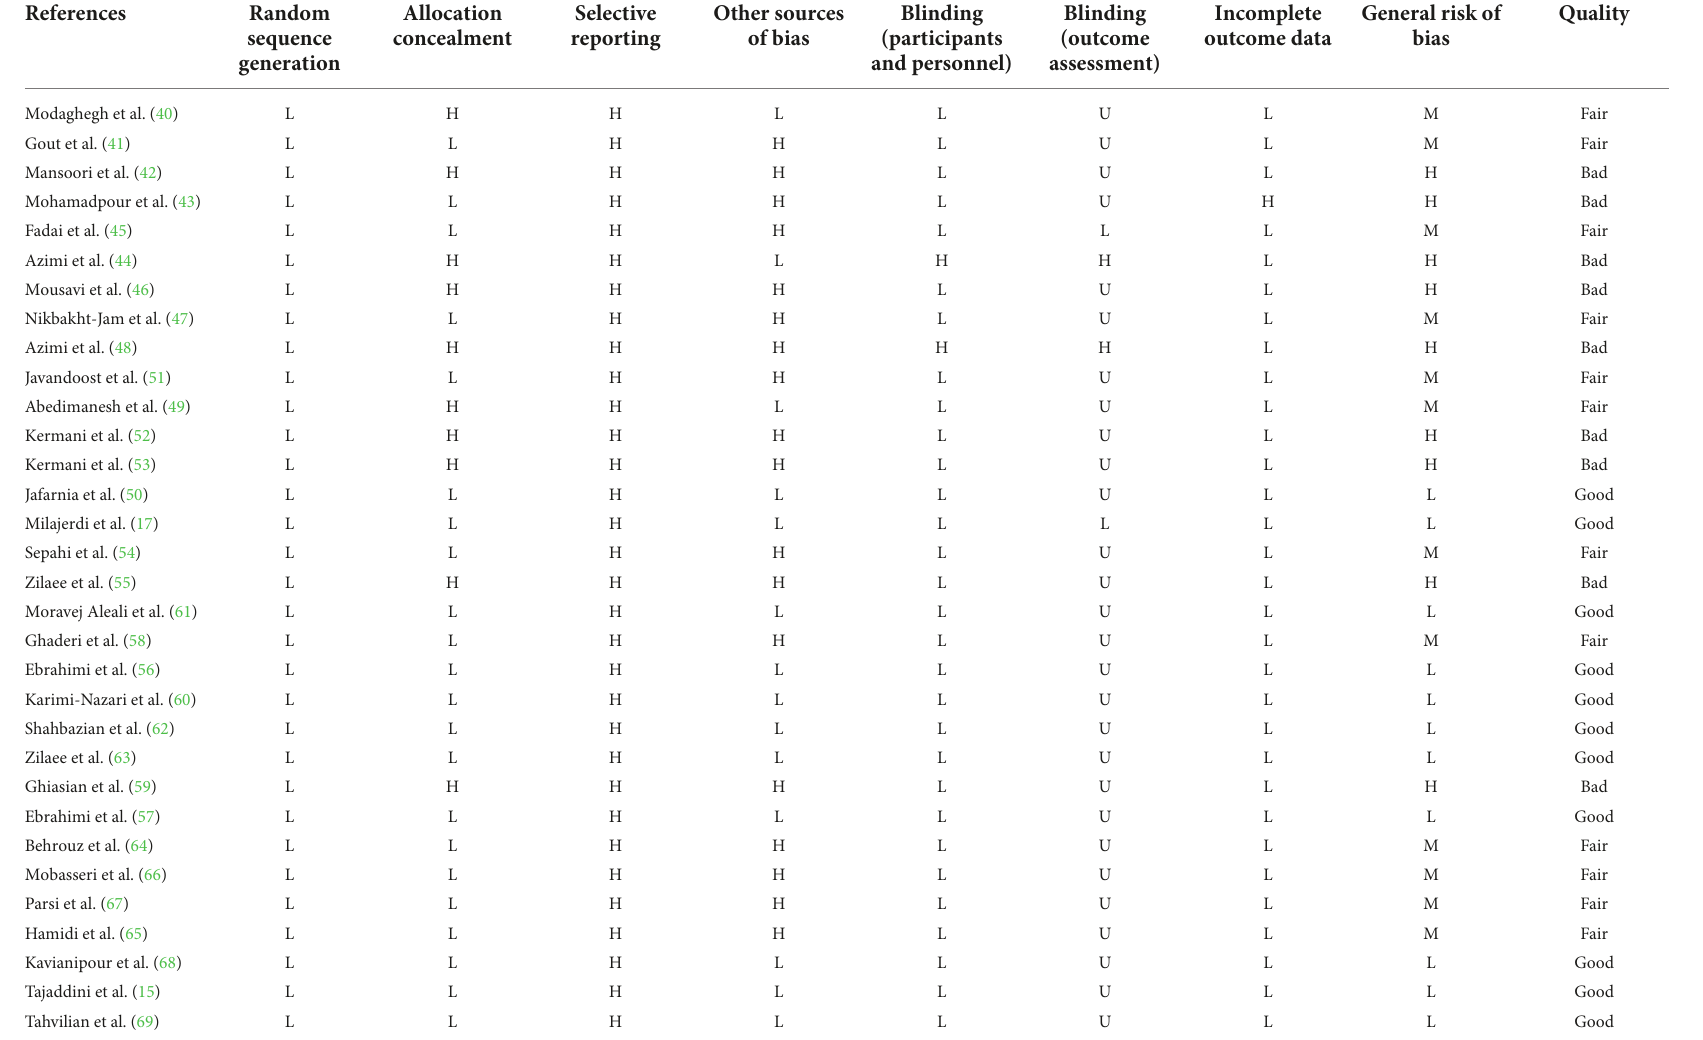
TABLE 2 Quality assessment (A summary of the risk of bias according to Cochrane